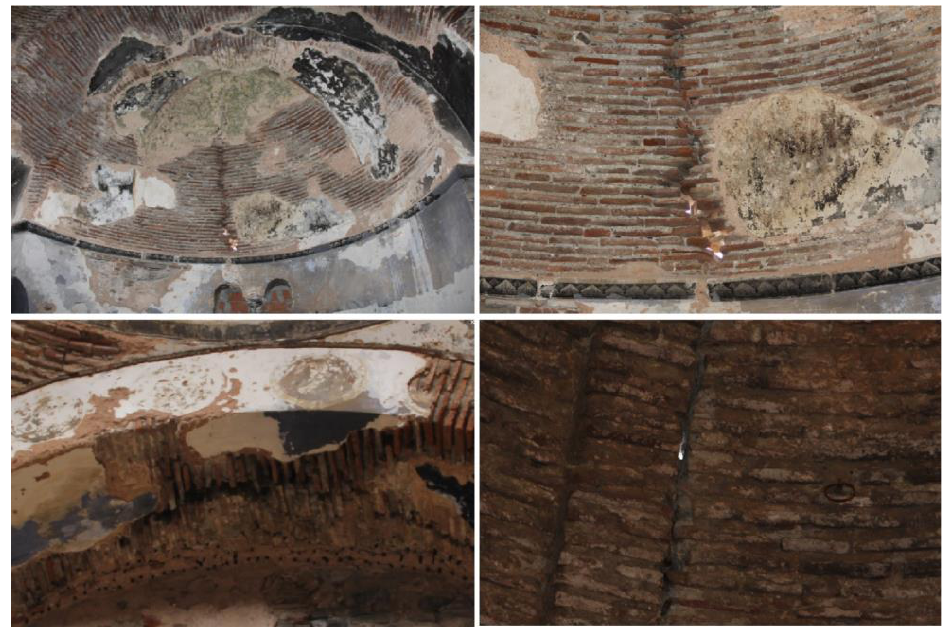
Figure 7. Cracks in the domes and arches.